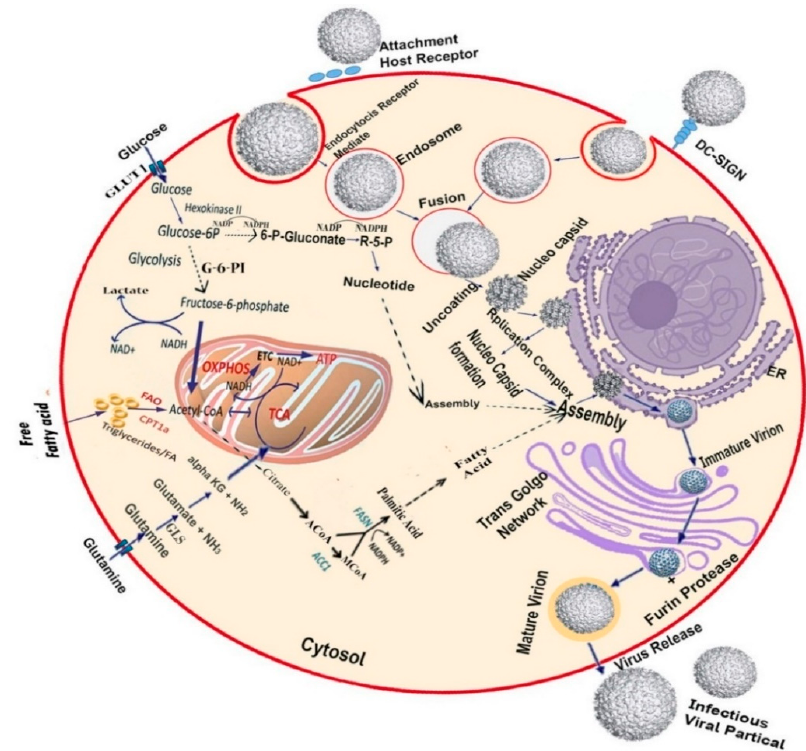
Figure 2. Host metabolic pathways are necessary for DENV replication: As an enveloped virus, DENV requires fatty acids for replication and virion envelopment, resulting in virus-mediated modifications in the host cellular systems. These modifications lead to alterations in glucose and glutamine metabolism, as well as fatty acid synthesis. At the primary level of infection, lipid droplets and nucleotides are reabsorbed into the endoplasmic reticulum (ER) and subsequently assemble with the DENV virus. Glucose uptake in DENV-infected cells may increase through the induction of the glucose transporter 4 (GLUT-4) or overexpression of glucose transporter 1 (GLUT-1) and hexokinase II (HK-II), the first enzyme of glycolysis. DENV infection alters glucose metabolism allosterically by